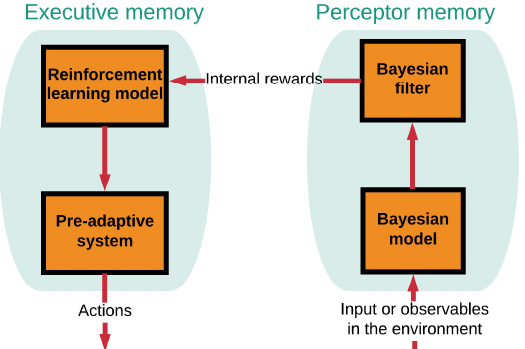
Figure 3. The functional brain-like block of the executive and perceptual memory in the cognitive dynamic system (CDS).